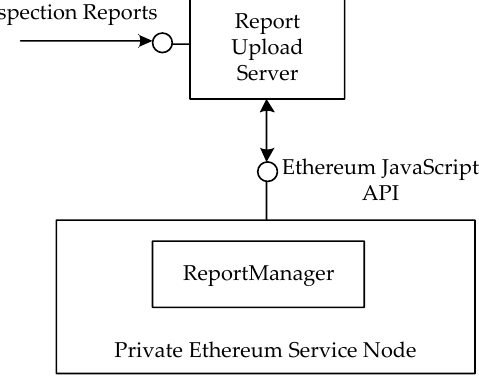
Figure 10. The experimental scenario.